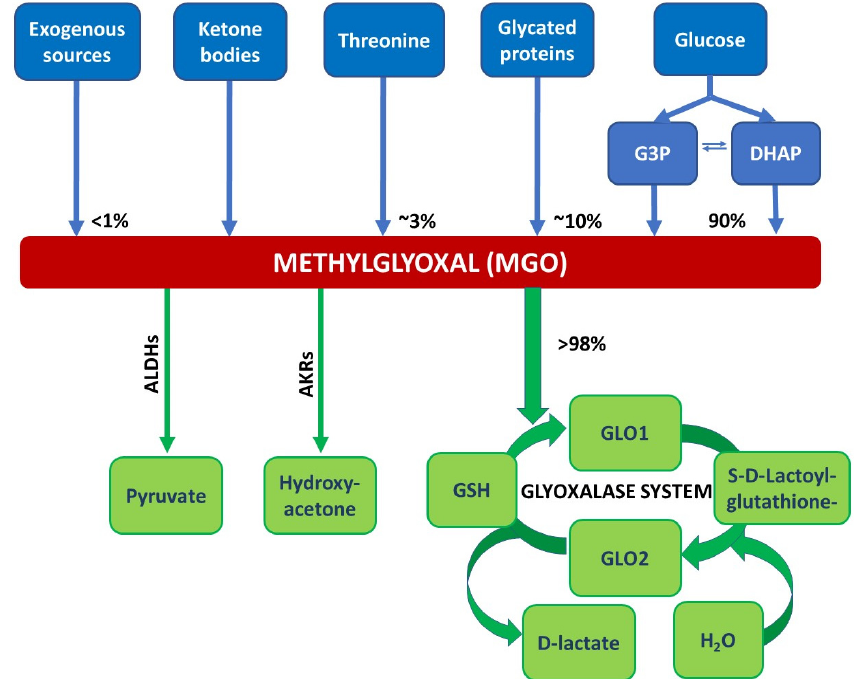
Figure 1. Reactions/sources that lead to the formation and degradation of MGO. MGO is formed via the spontaneous degradation of the triosephosphates dihydroxyacetone phosphate (DHAP) and glyceraldehyd 3-phosphate (G3P) originating from glycolysis. Other sources of MGO are exogenous sources like food and beverages, glycated proteins, threonine, or ketone bodies (acetoacetate). The glyoxalase system detoxifies MGO, in the first step, MGO forms a hemithioacetal with reduced glutathione (GSH). This serves as a substrate for glyoxalase 1 (GLO1). GLO1 catalyses the conversion of the hemithioacetal to S-D-lactoylglutathione. In the next step, glyoxalase 2 (GLO2) catalyses the hydrolysis of S-D-lactoylglutathione, forming D-lactate and recycling GSH. Minor degradation pathways of MGO involve aldehyde dehydrogenases (ALDHs) and aldose reductases (AKRs) yielding in pyruvate or hydroxyacetone, respectively; adapted from